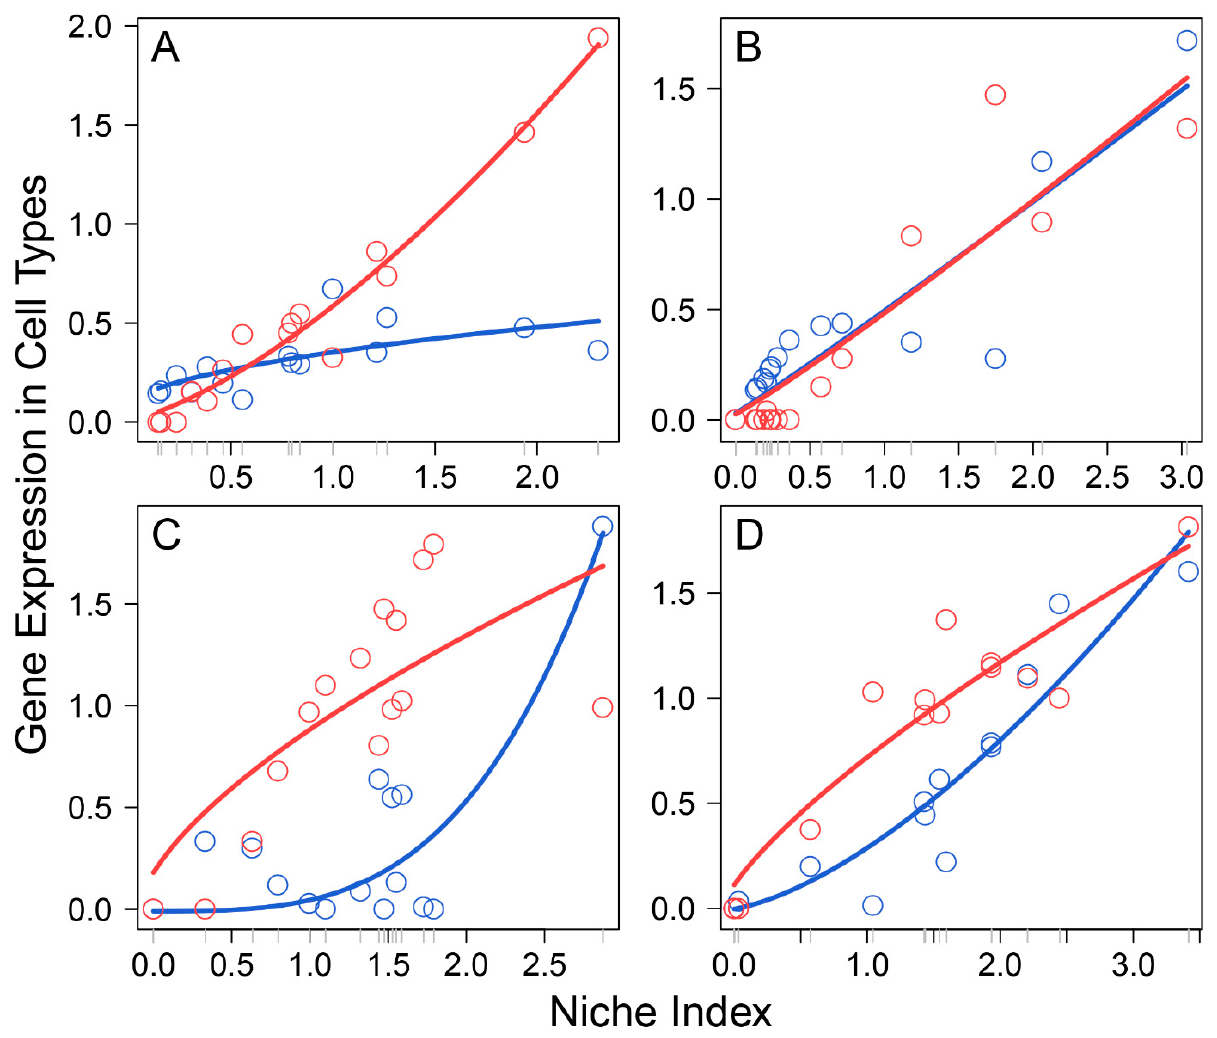
Figure 1. Allometric scaling of the expression level of a cell type, FGCs (blue) and somas (red), from an embryo against the NI of embryos for four randomly chosen genes, A2M ( A ), ADAP2 ( B ), AKR1B10 ( C ), and ANXA1 ( D ). Each dot denotes the value of gene expression on a cell type from an embryo, and lines present the fitting of a power equation to the data.